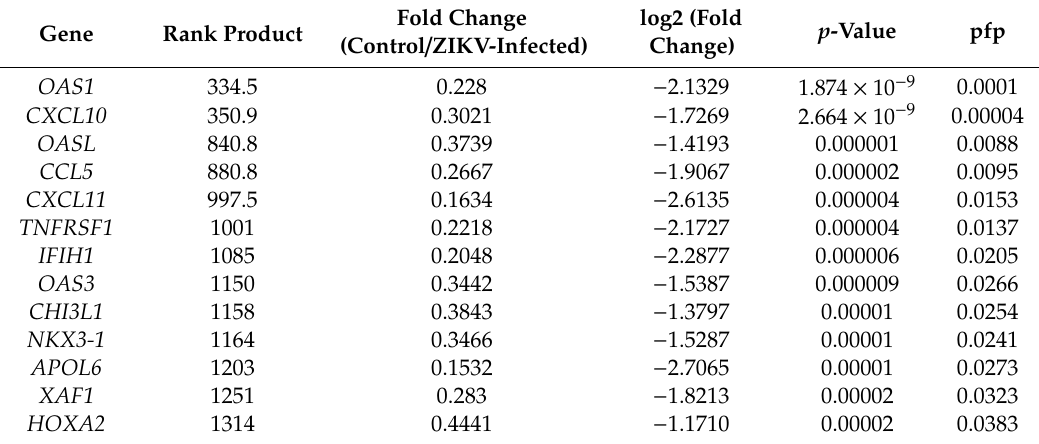
Meta-analysis results of three RNA-Seq assays involving human neural stem cells experimentally infected in vitro with Zika virus when compared to control cells, ranked by lowest p -values corrected by the percentage of false prediction, pfp (rank product